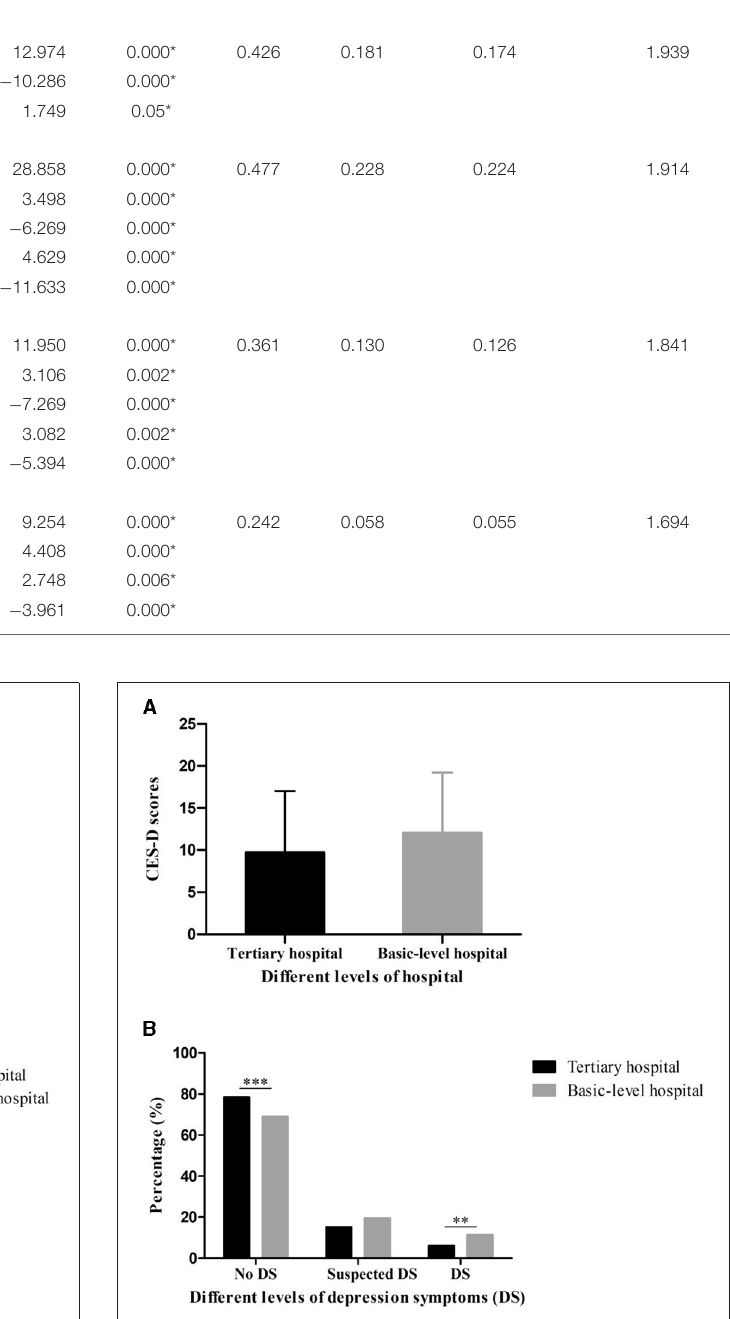
tension capable of activating pathological behaviors (32, 33). These mental health problems affected the efficiency of fighting against COVID-19, as well as their overall well-being